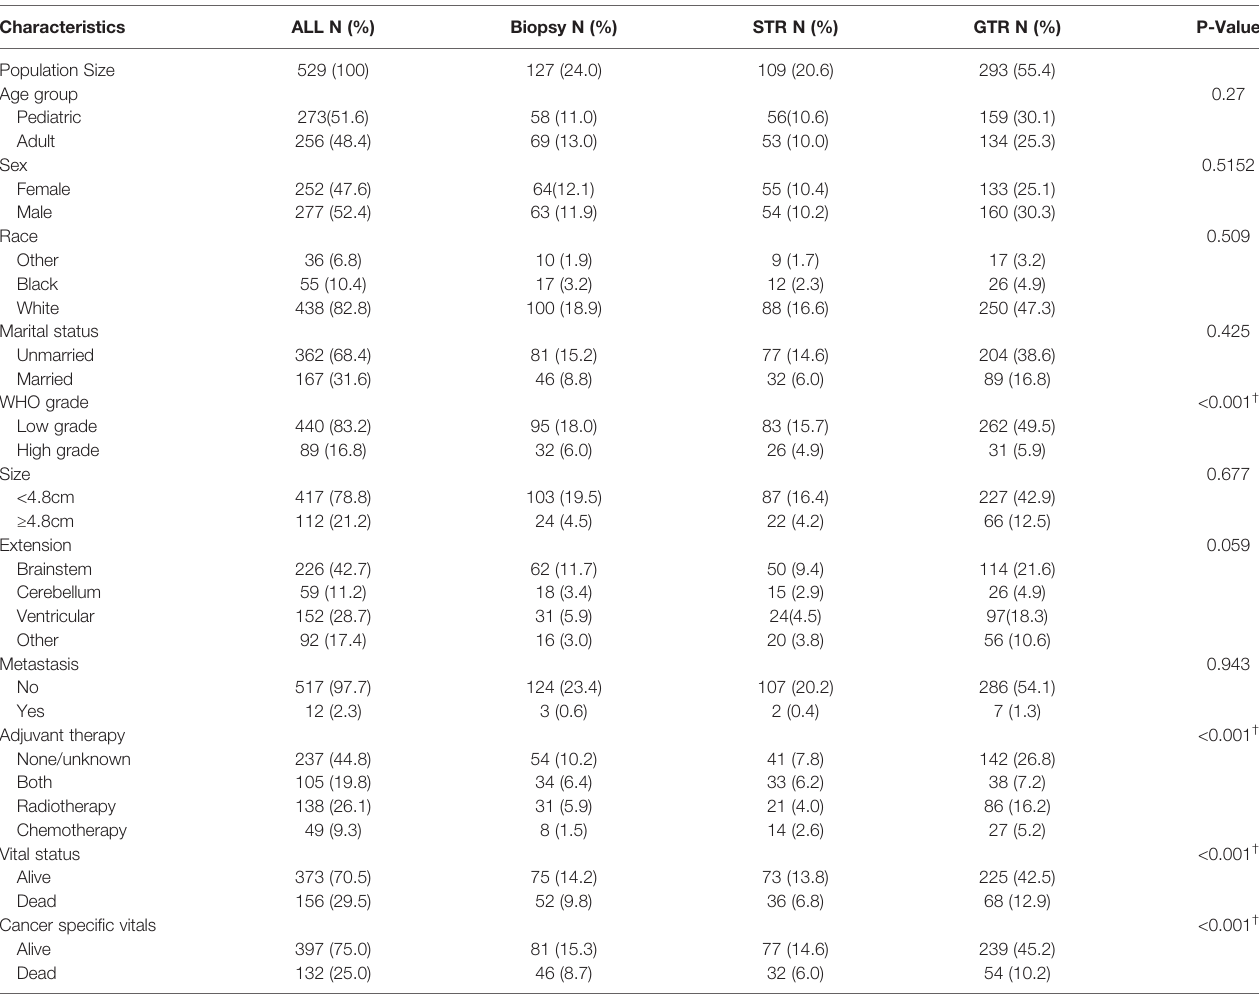
TABLE 1 | Patient demographics, tumor characteristics and treatment options of 529 patients with histologically con fi rmed BSG.